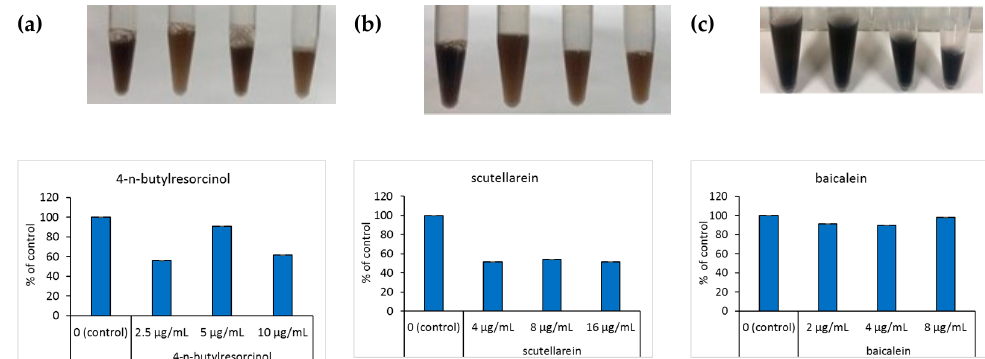
Figure 2. Effects of the tested compounds on the melanin content of B16 cells. The upper part of the figure shows the appearance of the cell suspension after the addition of the NaOH solution. The lower part of the figure represents the absorbance of the cell pellet dissolved in NaOH; absorbance was measured at 475 nm. Data are expressed as a percentage of the control. ( a ): 4-n-butylresorcinol; ( b ): scutellarein; ( c ): baicalein.